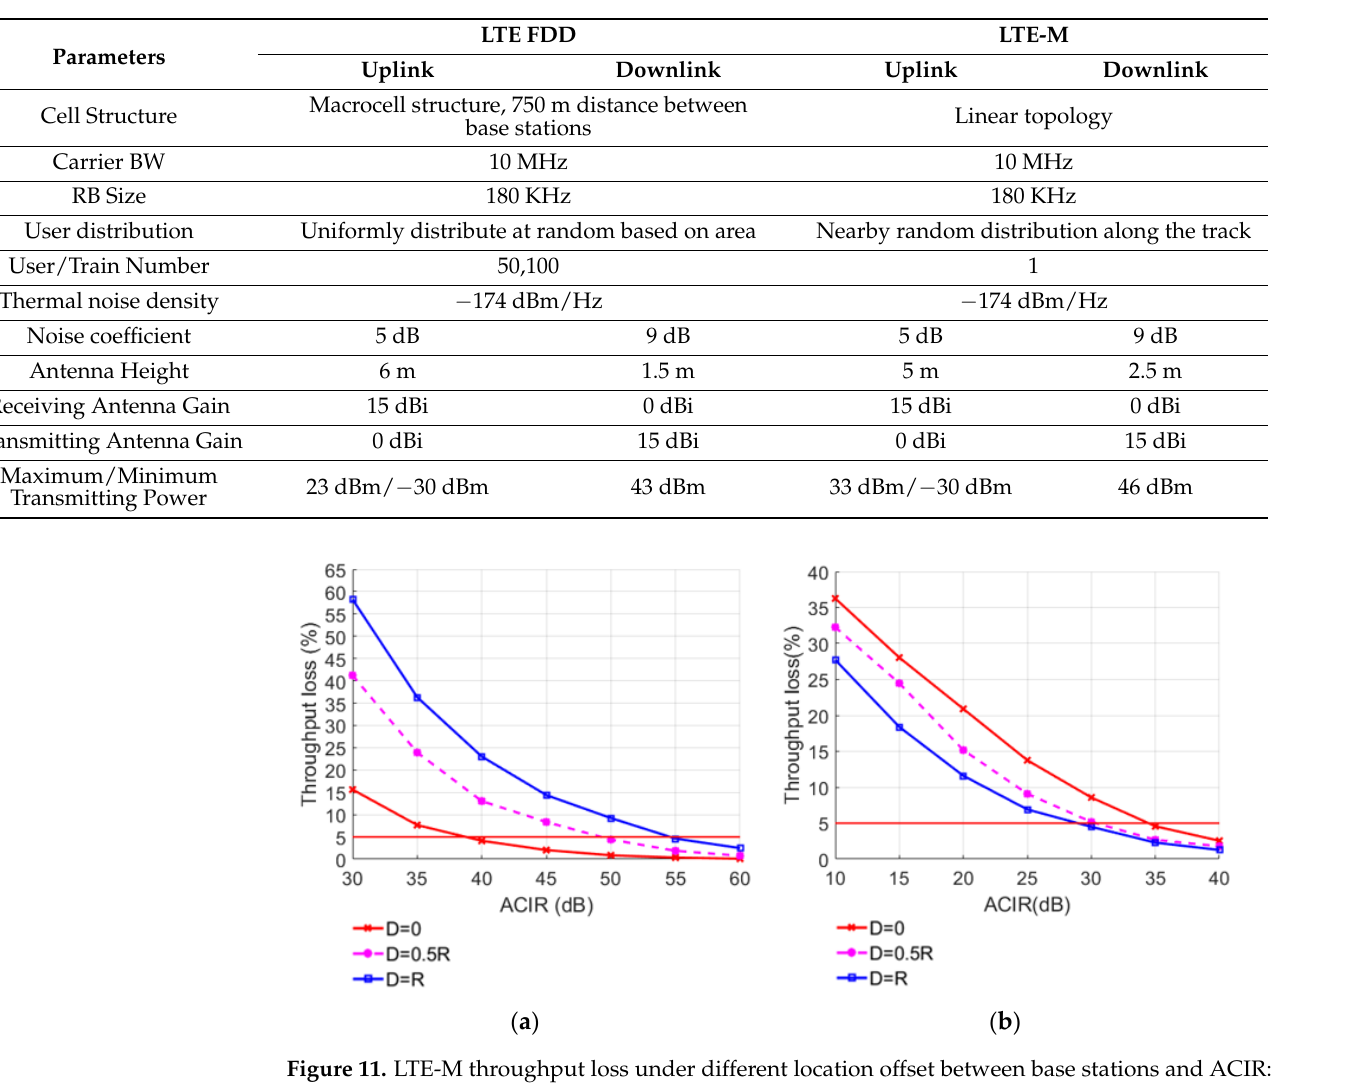
Table 11. The value of ACIR (dB) at 5% throughput loss.